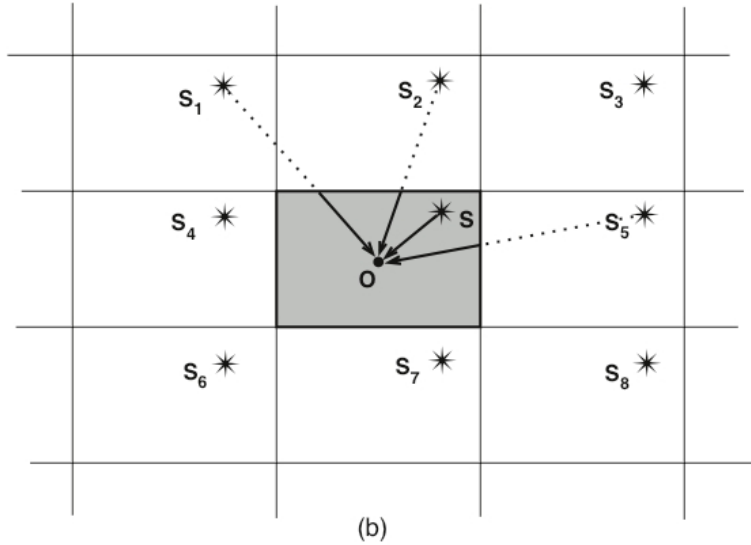
Figure 1. The Illusion of the Universal Covering Space. In the case of a 2D torus space, the fundamental domain, which represents real space, is the interior of a rectangle, whose opposite edges are identified. The observer O sees rays of light from the source S coming from several directions. He has the illusion of seeing distinct sources S 1 , S 2 , S 3 , etc. , distributed along a regular canvas which covers the UC space—an infinite plane.